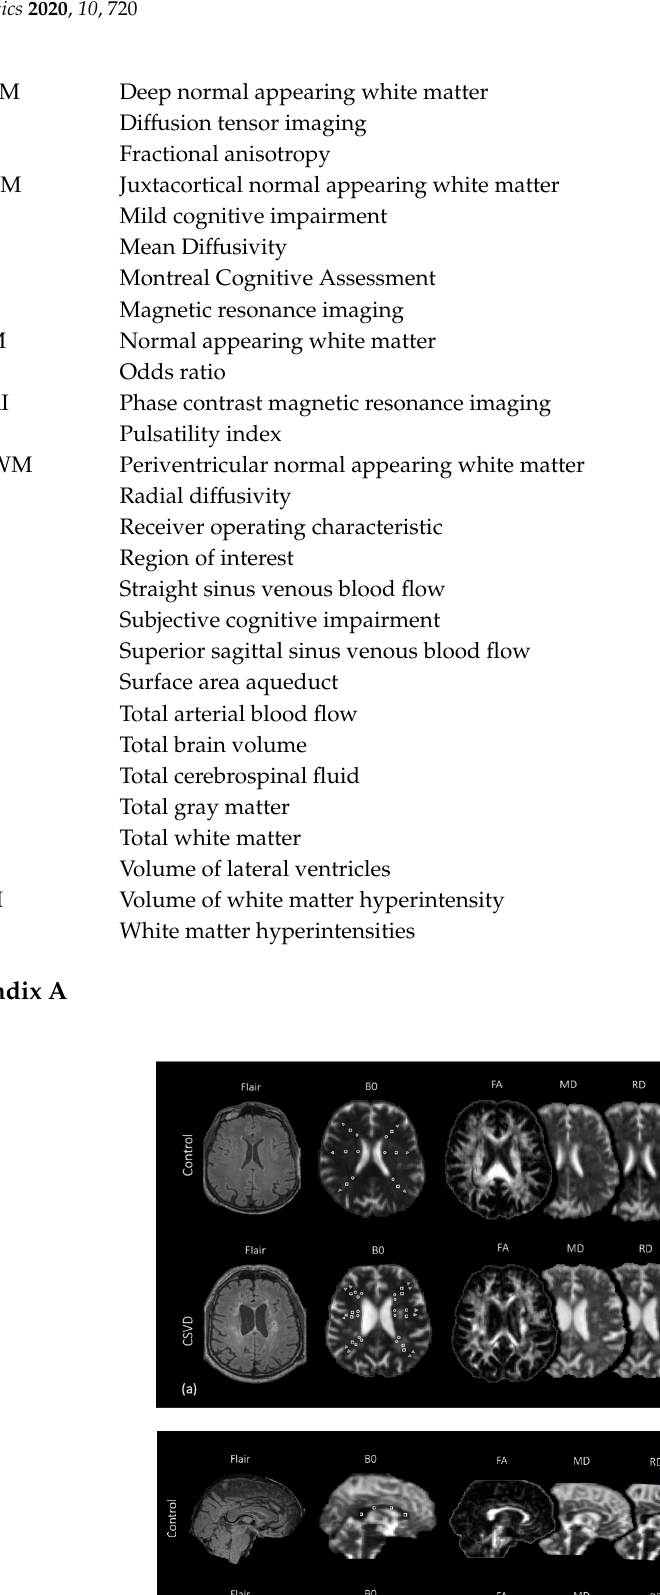
Figure A1. Selection of ROI in the periventricular (circle), deep (square), and juxtacortical (triangle) WMH and NAWM ( a ); anterior, mid-anterior, mid-posterior, and posterior CC ( b ); anterior, middle,